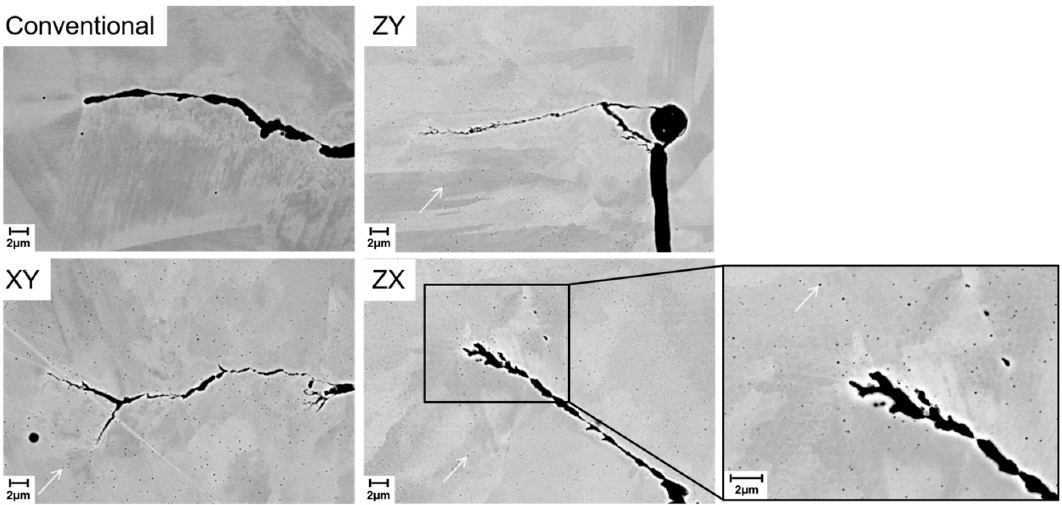
Figure 16. Finely distributed SiO2 particles in the additively manufactured 316L specimens indicated by white arrows. by white